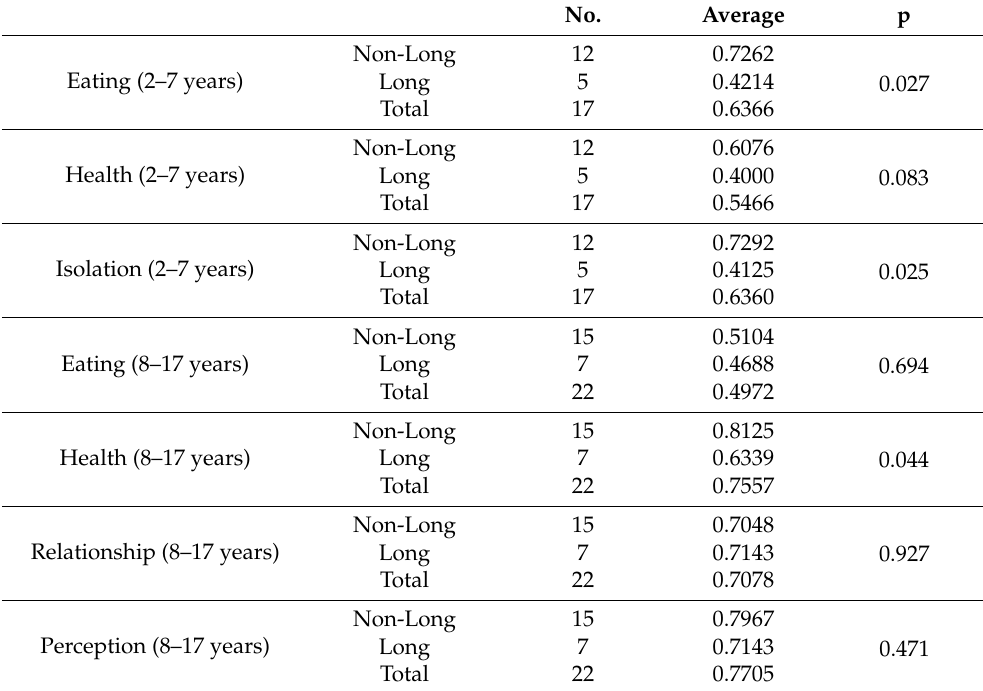
Table 6. Score of quality of life according to age group.